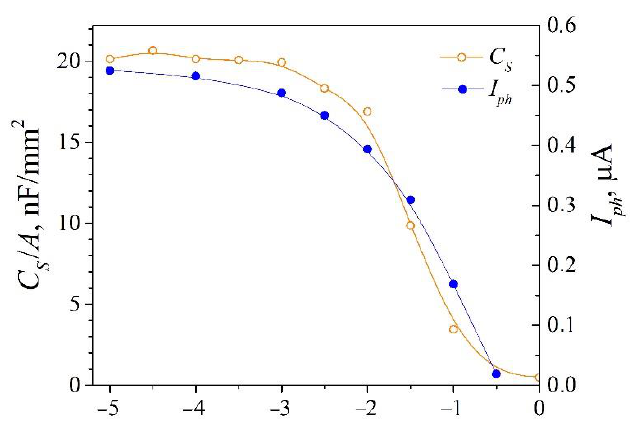
Figure 5. Dependencies of semiconductor surface layer capacitance C S (open orange dots, left axis) and laser induced photocurrent I ph (solid blue dots, right axis) on reverse bias voltage across the MOS-1 sample.